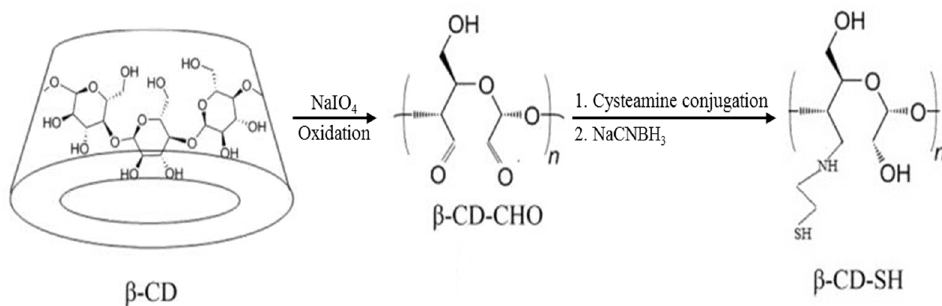
Scheme 3. Schematic illustration of oxidation and subsequent cysteamine conjugation via reduc- tion β -CD (slightly modified and reproduced with permission [37], copyright 2016, American